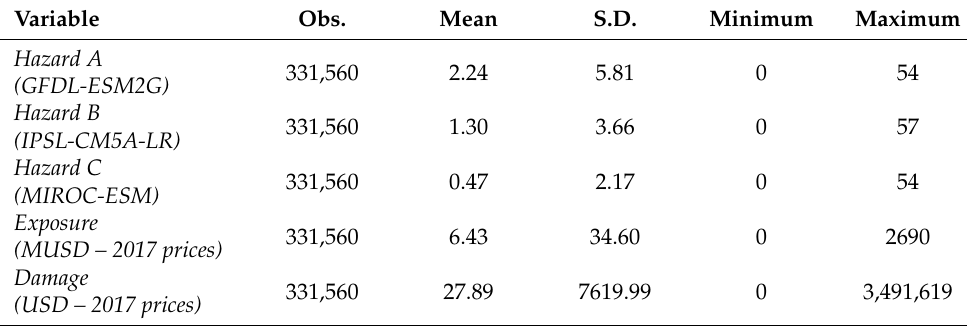
Table 2. Summary statistics for calibration sample